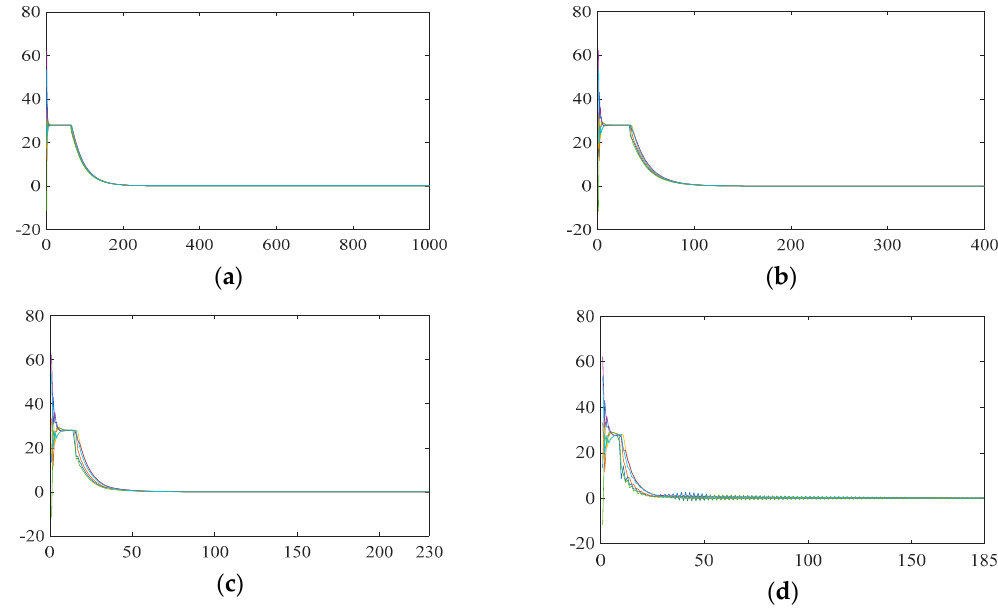
Figure 9. The performance of mismatch when η = 0.001 ( a ), 0.005 ( b ), 0.01 ( c ), and 0.05 ( d ).